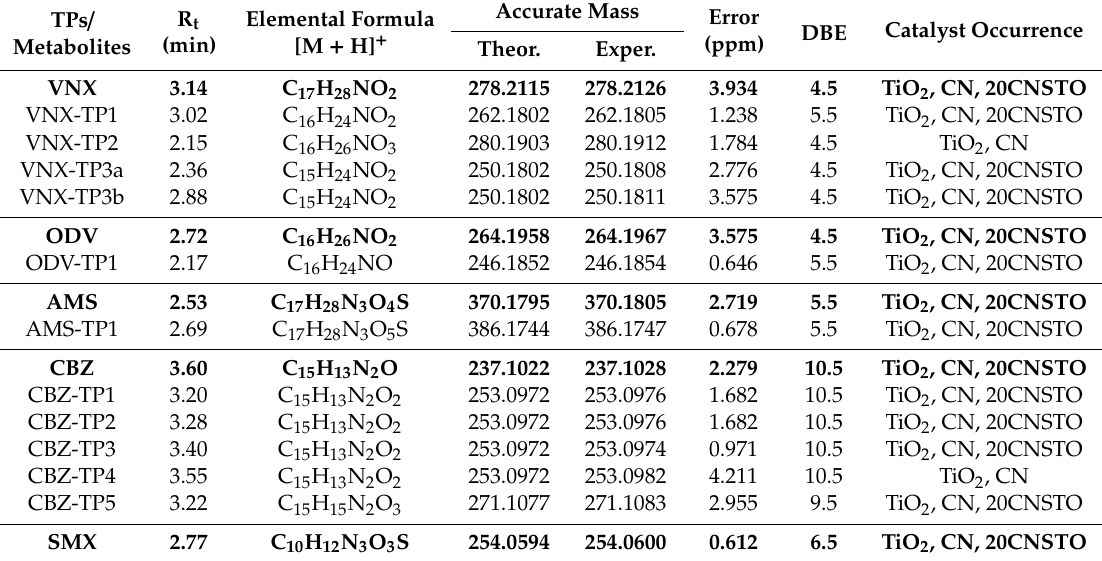
Table 6. Retention time (R t ), elemental formula, experimental and theoretical mass, mass error deviation and double bond and ring equivalent number (RDB) of metabolites / transformation products (TPs) identified during the three catalysts treatment by UHPLC-Orbitrap MS using the in-house database (molecular ions in